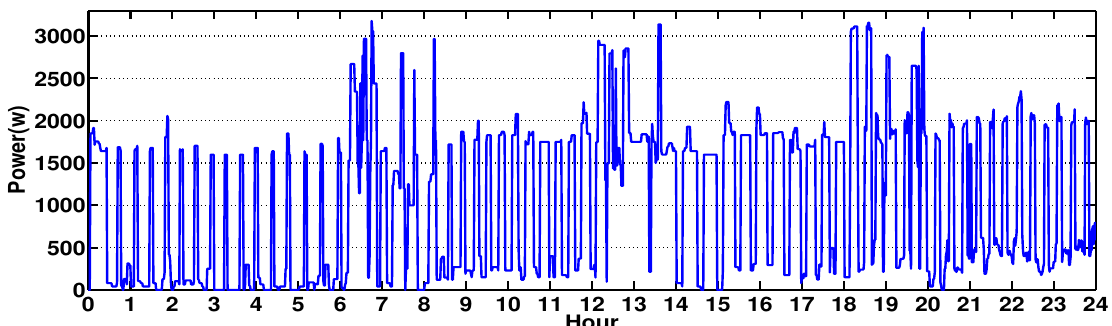
Figure 9. Building power consumption after using smart plugs and energy management strategy.